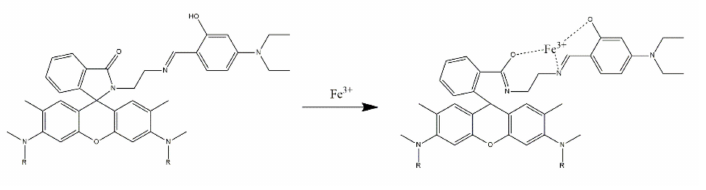
Figure 24. The proposed binding mechanism of RS (Table 1, No. 30) to Fe 3+ [59]. A novel rhodamine-based sensor (RhB-EDA) was constructed by functionalizing rho- damine with the Fe 3+ recognition group ethylenediamine (EDA) (Table 1, No. 32) [61]. The colorless and non-fluorescent RhB-EDA turned pink and showed high fluorescence in the presence mechanism (Figure 25).